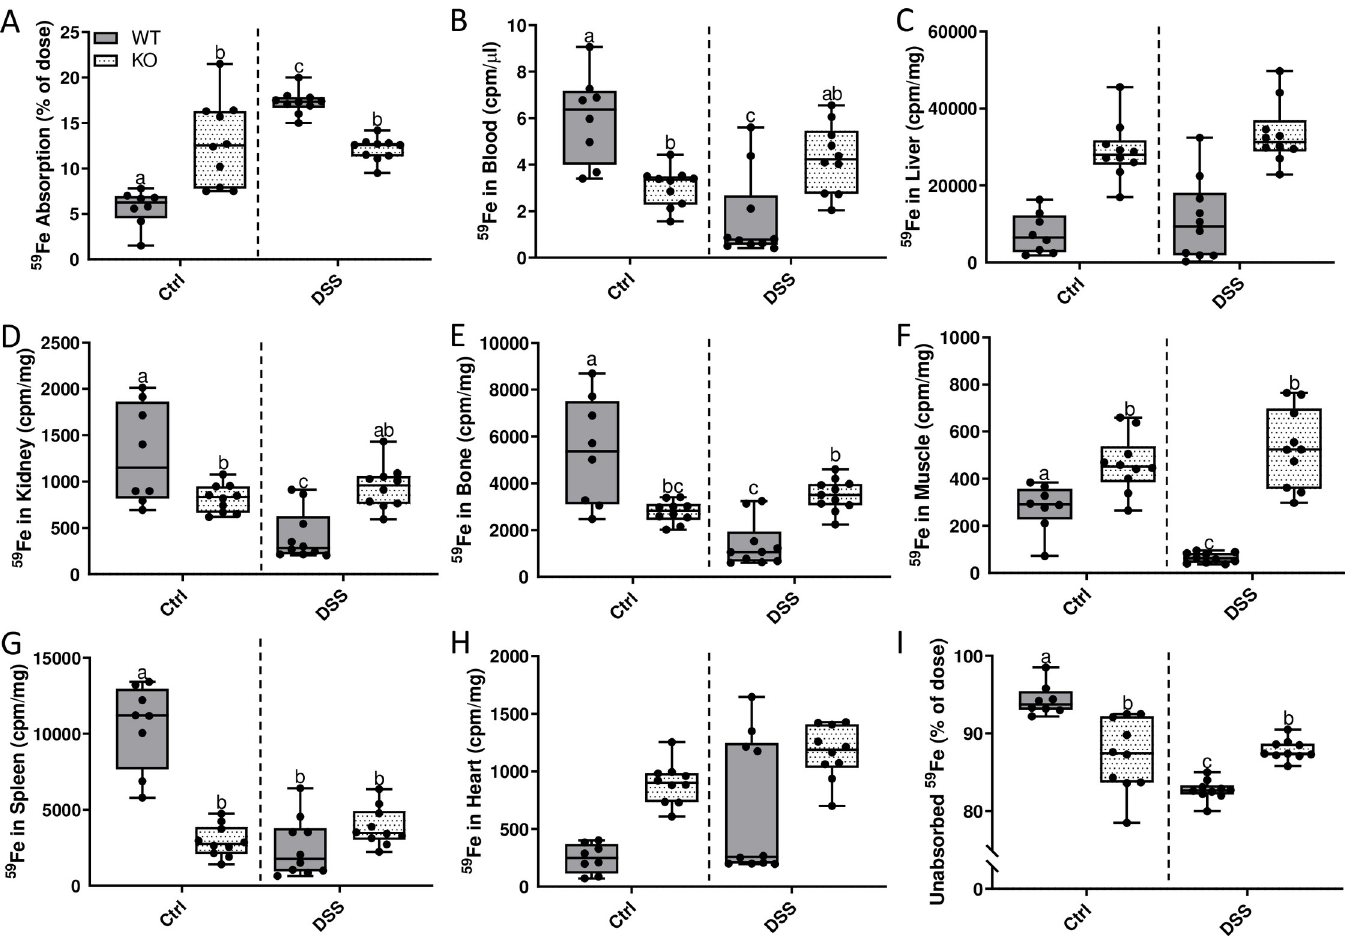
Fig 24. DSS treatment differentially influences intestinal 59 Fe absorption and tissue distribution in female WT and Hamp KO rats. Intestinal iron absorption and 59 Fe tissue distribution was determined using the transport assay described in the Materials and methods section ( A ). Distribution of 59 Fe in several tissues was also assessed by gamma counting ( B - H ). The percentage of unabsorbed 59 Fe is also depicted ( I ). All data are presented as box plots for 8–10 animals from two independent experiments and were analyzed by 2-way ANOVA followed by Tukey’s multiple comparisons post-hoc test. Groups labeled with different letters are significantly different from one another ( p � 0.0328). Genotype × Treatment p < 0.0007 ( A-B, D-G, I ), Genotype p < 0.0001 ( C, F, G-H ), Treatment p � 0.0041 ( B, D, E, H